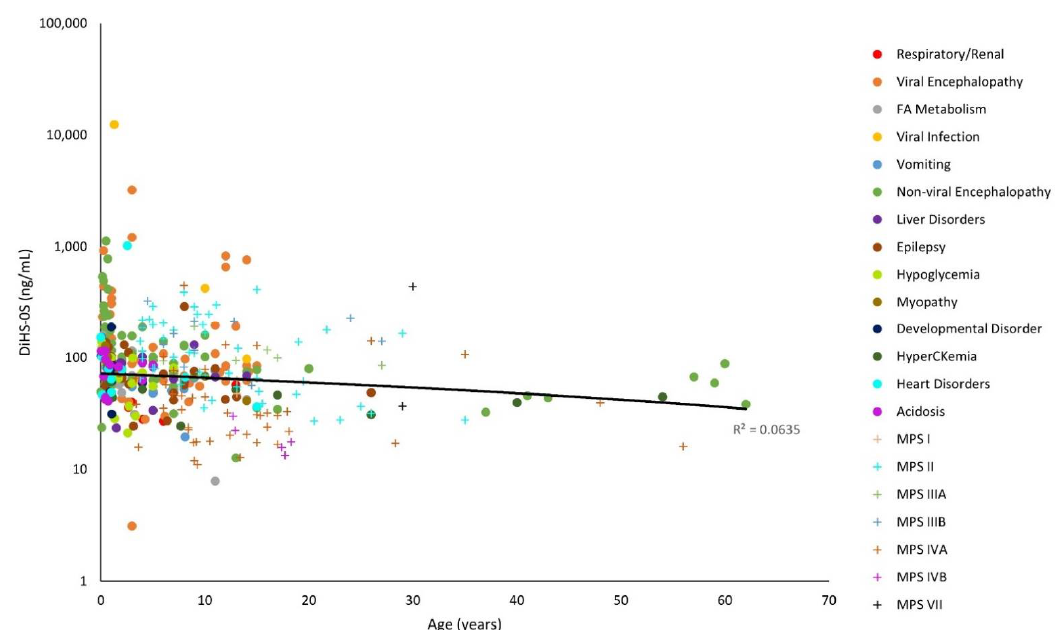
Figure 1. O -sulfated heparan sulfate ( ∆ DiHS-0S) levels with age on a logarithmic scale. The linear trendline of control values is shown as a black line, and glycosaminoglycan (GAG) values of patients with mucopolysaccharidosis (MPS) are shown as plus marks.